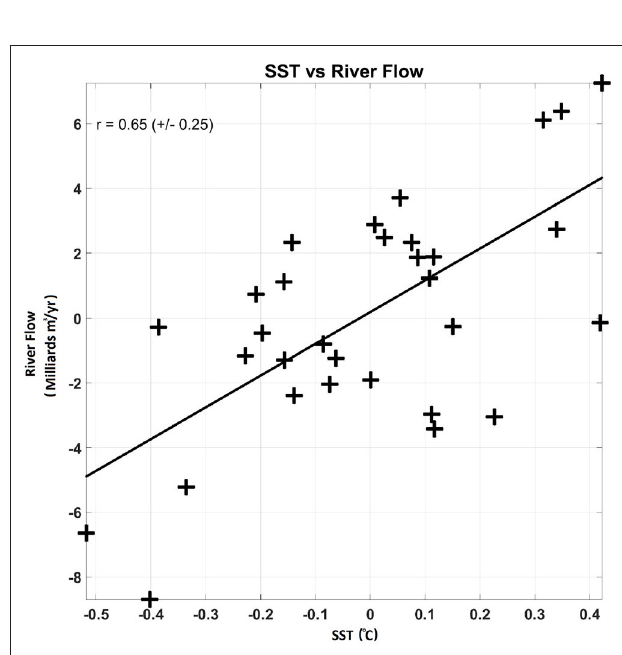
FIGURE 4 | Scatter plot of correlation between detrended annual Shatt-Al-Arab river discharge and detrended annual SST for 1982–2015. SST: sea surface